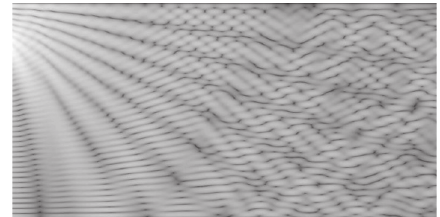
Figure 8: Screenshot of the HLSL code. A scaled mapping of 64 color scales is used, and the maximum and minimum values of TL are − 18.0972dB and −